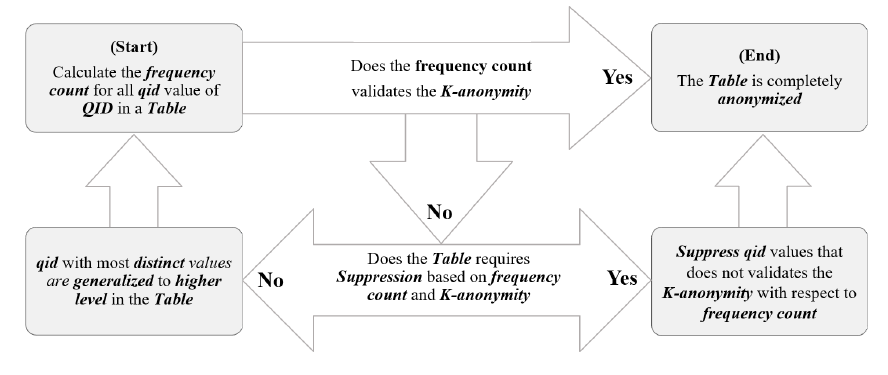
Figure 3. Datafly